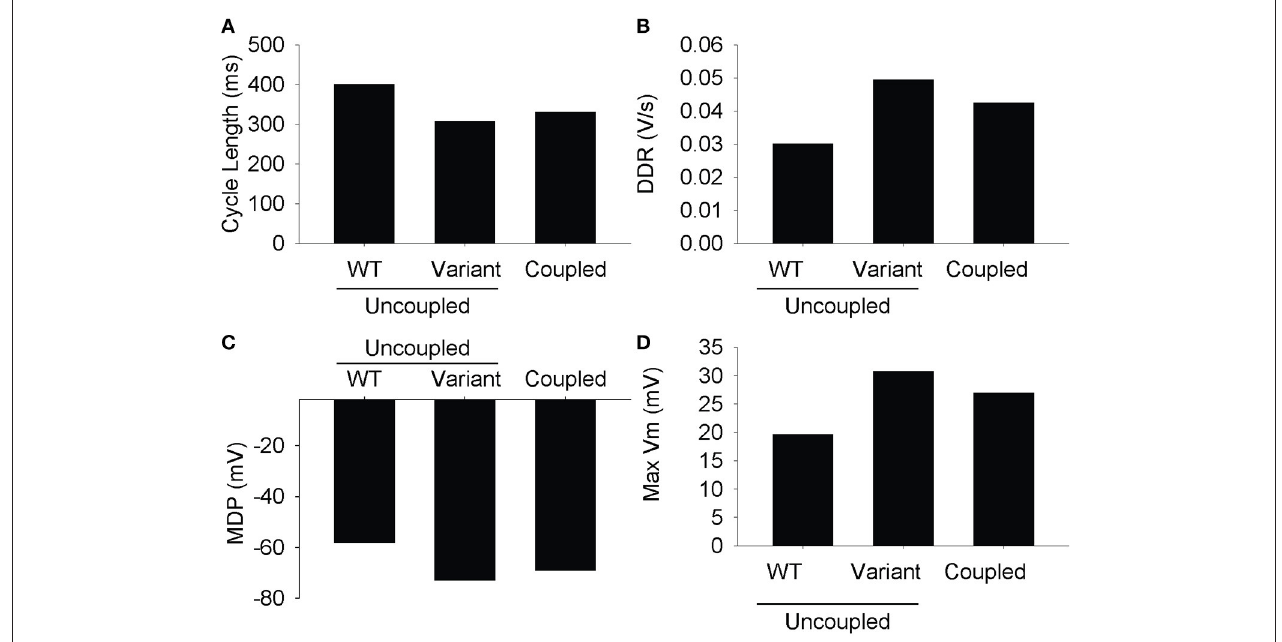
FIGURE 3 | Measured steady state values from the last action potential in the simulation. The differences between the two cells are resolved at full conductivity to a value somewhere between the two cells. (A) Cycle length, (B) diastolic depolarization rate, (C) max diastolic potential, ( D ) max voltage.